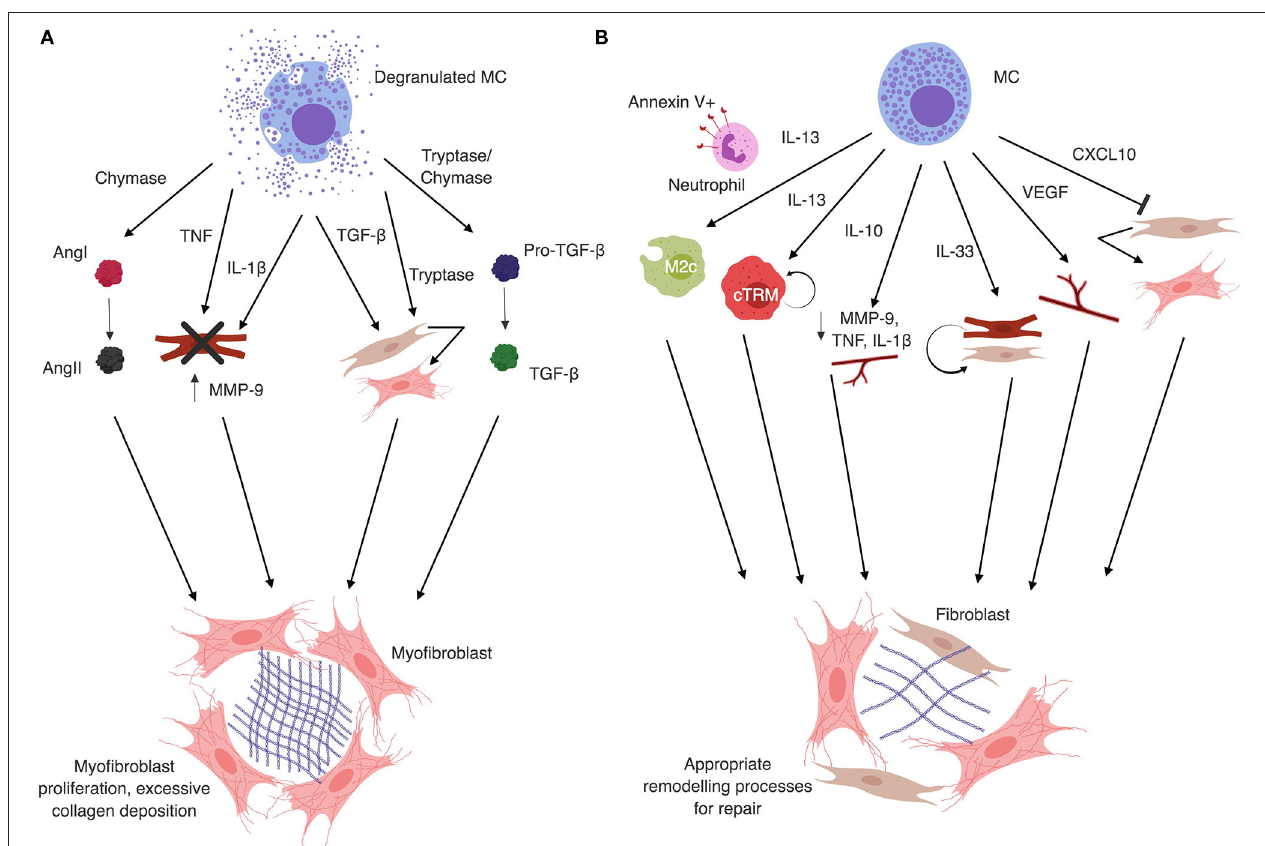
FIGURE 1 | (A) Mast cell granule products are typically associated with fibrosis. Mast cell chymase converts Angiotensin I (AngI) to AngII independently of ACE. AngII generation directly contributes to fibrosis by inducing differentiation of fibroblasts to myofibroblasts. Mast cell degranulation-derived TNF and IL-1 β induce cardiomyocyte apoptosis, MMP-9 production and inflammatory cell recruitment that enhances tissue remodeling. Mast cell tryptase can act directly on fibroblasts to induce proliferation and differentiation to the myofibroblast phenotype. Tryptase and chymase both act on latent TGF- β to convert it to the active form, which also induces fibroblast differentiation to the myofibroblast phenotype and collagen deposition. Additionally, mast cells release TGF- β upon degranulation, further contributing to the activation and differentiation of fibroblasts. (B) Mast cell secretion products can protect against fibrosis. Mast cells can produce IL-13, which in the presence of apoptotic neutrophils can induce M2c phenotype macrophages. M2c macrophages are associated with decreased fibrosis. IL-13 can also induce proliferation of local cTRM via IL-4R α signaling, which are known to be anti-fibrotic. Mast cells can also produce IL-10, which acts in the heart to decrease IL-1 β and TNF levels, reduce MMP-9 expression and activity, and increase capillary density to reduce fibrotic remodeling. IL-33, which is released by stressed cardiomyocytes and fibroblasts, but can also be produced by mast cells, has been shown to protect cardiomyocytes and fibroblasts from death under hypoxic conditions. This